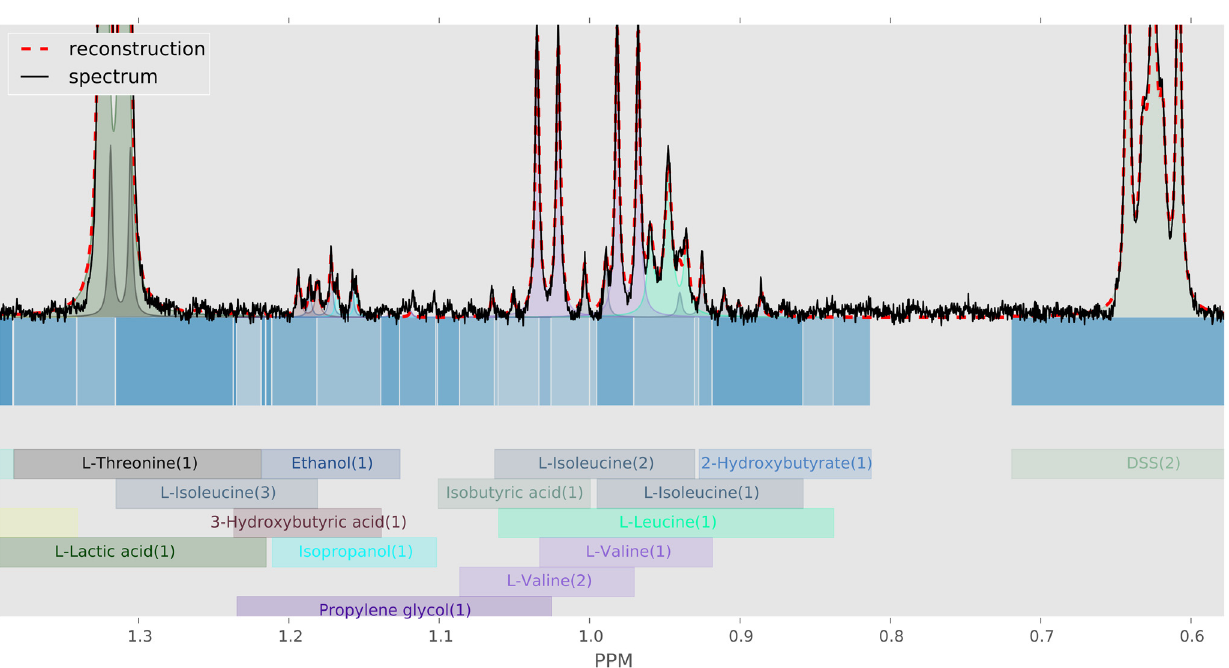
Fig 3. Construction of spectral regions. Partitioning of spectrum X into continuous blocks X I (cid:2) X . Here each block is shown with a different shade of blue, below the horizontal axis. The domain of influence of each cluster is also indicated with coloured blocks, where each cluster assumes the same colour in reconstruction ^ s of the spectrum (above horizontal axis).